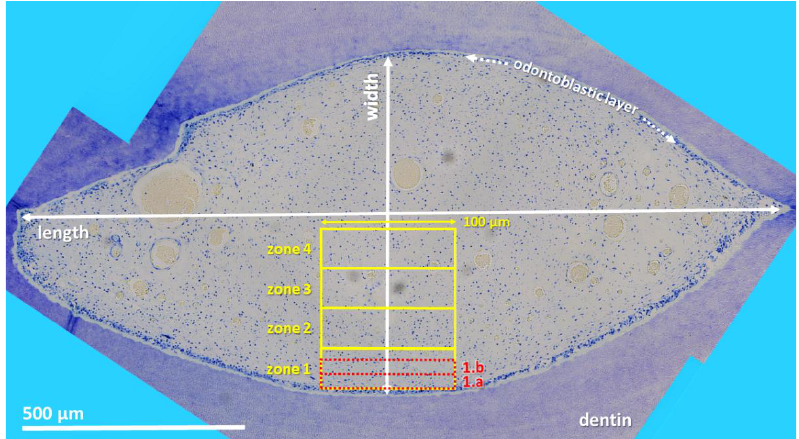
Figure 1. Cheek tooth (108) from a 21-year-old horse, toluidine blue-stained horizontal histological section (central level). Using LAS X, XY Live Image Builder, 80 – 100 single high-resolution images were recorded. For histomorphological purposes zones were defined. Zones 1 – 4 (yellow rectan- gle): constant length (100 µm) and recalculated width. Zones 1.a and 1.b (red rectangle): constant length (100 µm) and width (20 µm).